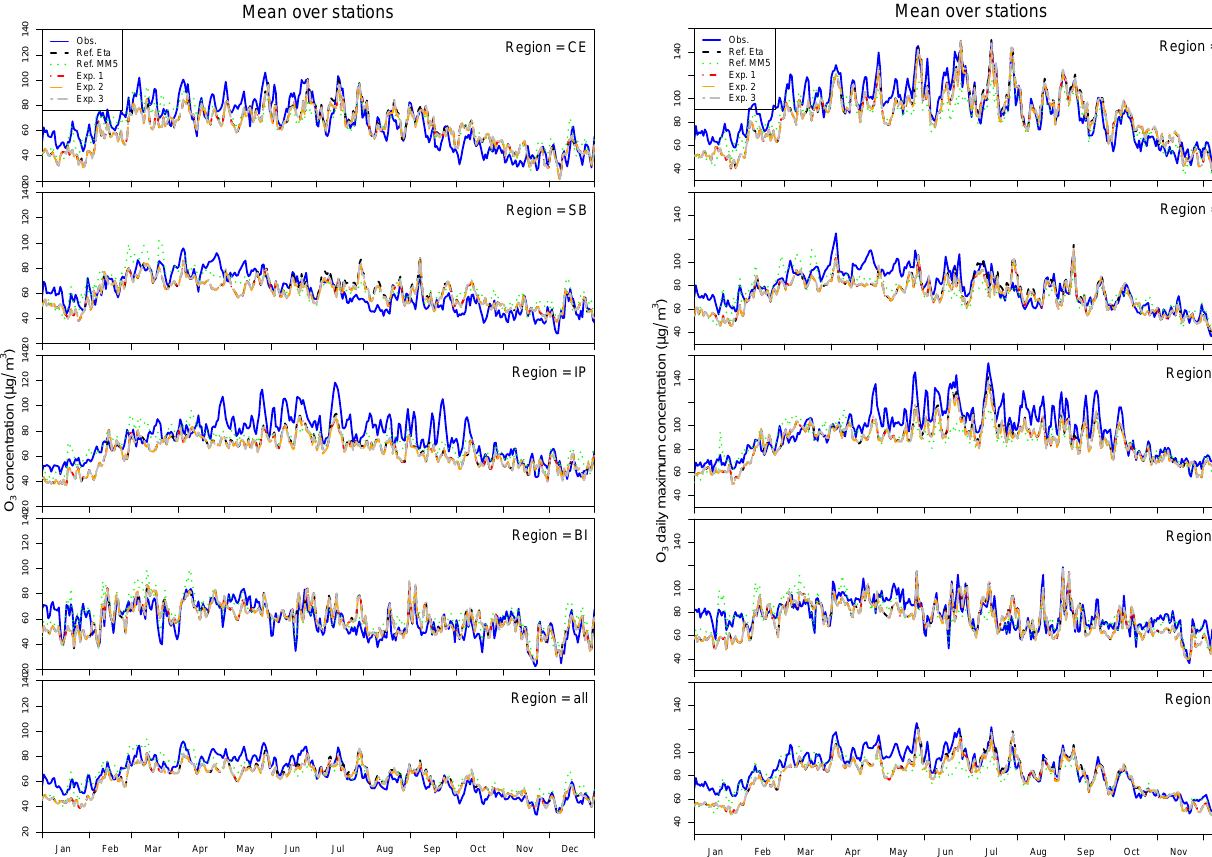
The ˆ χ 2 metric was calculated for simulations Exp. 1–3 for 33 each month, and are shown alongside the theoretical distri- bution statistic (Fig. 2). The background errors were deter- mined, as described above, by the difference between paired forecasts. Assuming that these have been appropriately spec- ified, then the ˆ χ 2 results reflect on the observation errors. Exp. 1 and 2 yield ˆ χ 2 values consistently less than 1.0, indi- cating that the magnitude of observed residuals was smaller than that prescribed by the error variances. The observation errors would need to be inflated substantially (as to compen- sate for correlated observation errors) to correct this. The ˆ χ 2 values for Exp. 1 were lower than for Exp. 2, suggest- ing that the impact of observation error correlations was less severe for the Exp. 2, where observations were thinned. For Exp. 3, which used fixed observation error variances as well as thinned observations, the ˆ χ 2 values show a much closer fit to the χ 2 distribution compared to Exp. 1 and 2. This is 1 partly attributable to the fact that none of the prescribed ob- servation errors for this experiment were relatively small (i.e. from the lower tail of the reported DOMINO